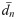
Overall distribution of individual users’ distance from the centers of App functions categories (dn)(where g1: Coefficient of skewness, g2: Coefficient of kurtosis, dn¯: The average value of dn).